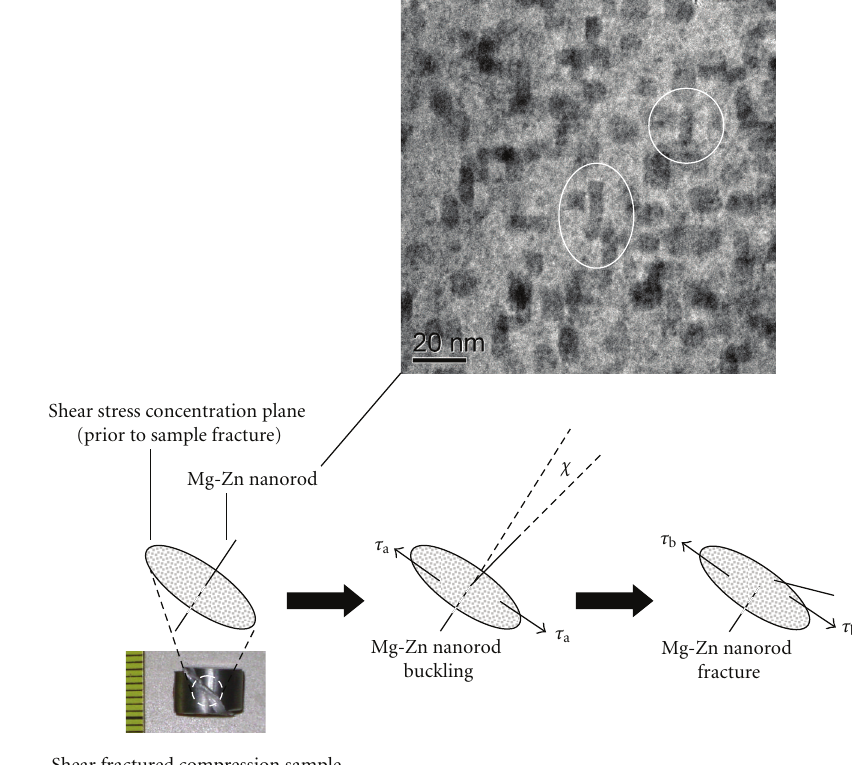
Figure 5: Schematic diagram illustrating compressive shear buckling of brittle Mg-Zn nanorod (circled in TEM micrograph) in AZ91/ ZK60A/AlN nanocomposite. τ a and τ b represent planar shear stresses where τ a < τ b . χ (exaggerated) represents very low angular deflection of the brittle Mg-Zn nanorod during